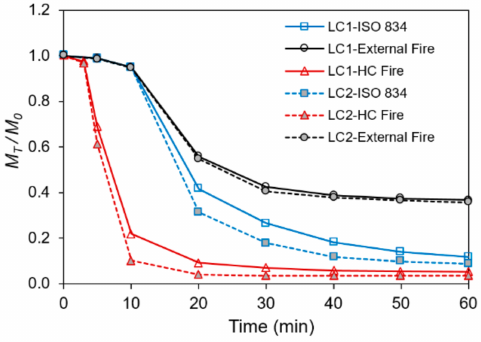
Figure 13. Reduction ratio of the composite beam without fire